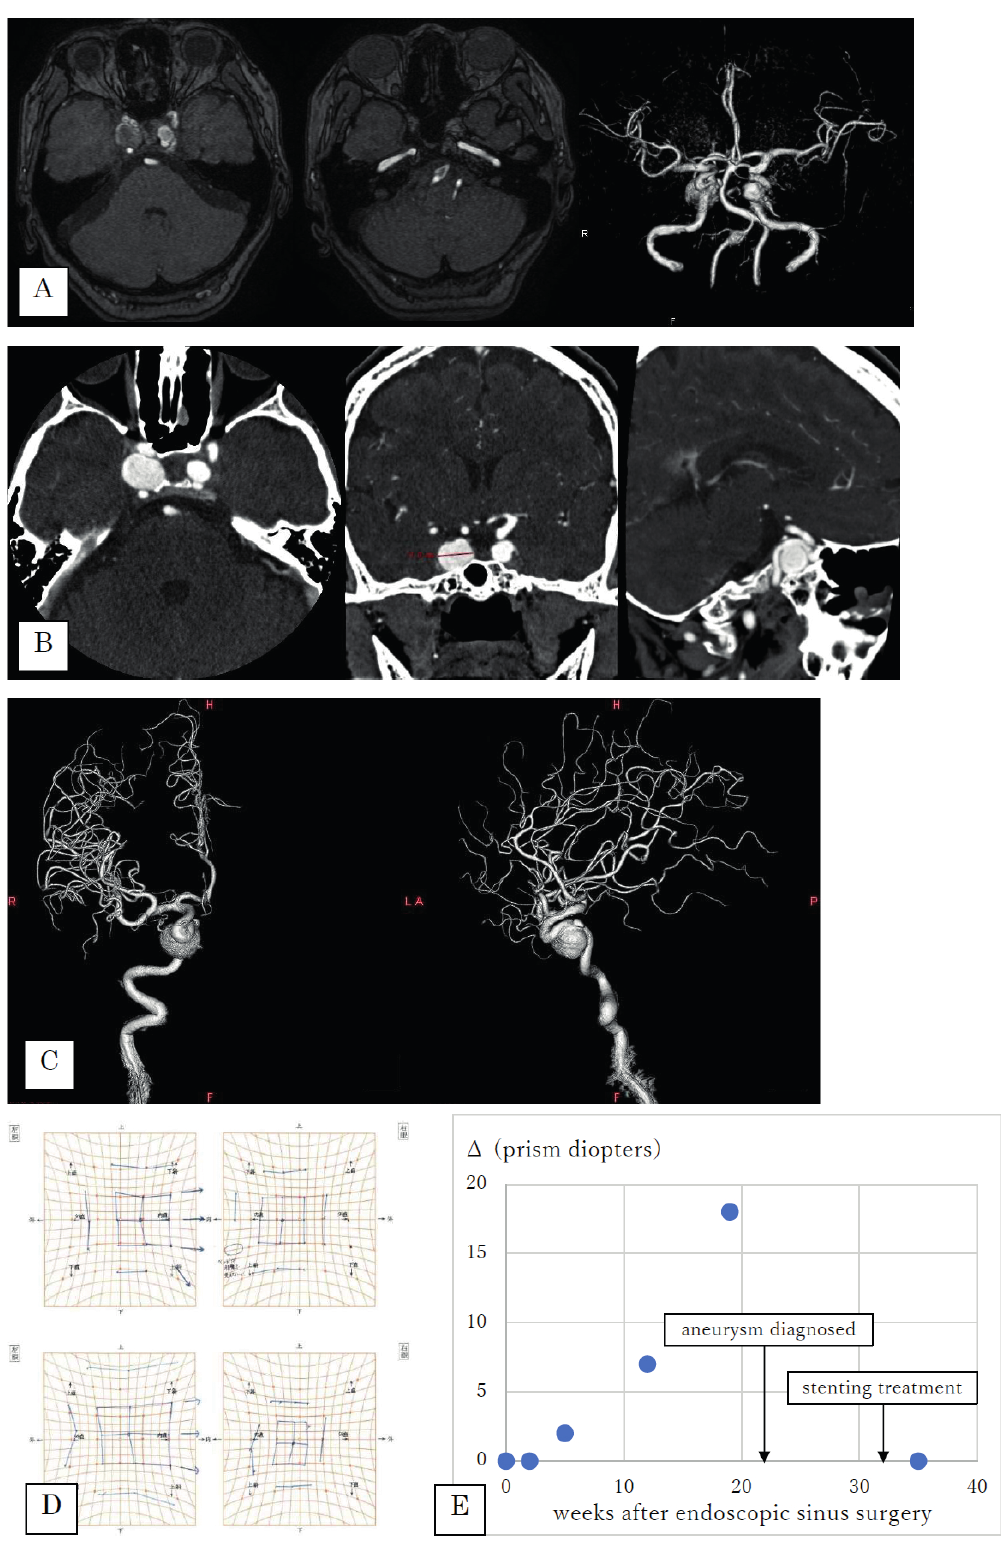
Figure 2. Image findings of cavernous carotid aneurysms and the Hess chart. (A) Magnetic resonance angiography of aneurysms (bilateral cavernous carotid aneurysms [CCAs] and a right vertebral aneurysm; right CCA: 17 x 13 mm; left CCA: 10 x 8 mm) (B) Computed tomography (CT) with contrast- enhancement of CCA (axial, coronal, and sagittal plane of CCA. Maximum diameter = 17 mm.) (C) Digital subtraction angiography with a CT angio- gram of the right internal carotid artery clearly shows an aneurysm of the cavernous sinus and its origin. (D) Hess charts obtained before (left) and after (right) stenting treatment. Diplopia decreased from 12 Δ to 4 Δ